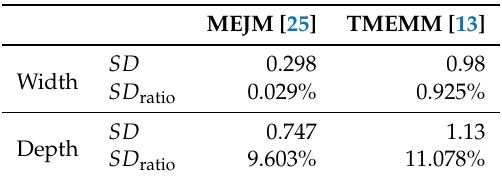
Table 1. SD and SD ratio comparison between mask electrolyte jet machining (MEJM) [25] and through mask electrochemical micro-machining (TMEMM)